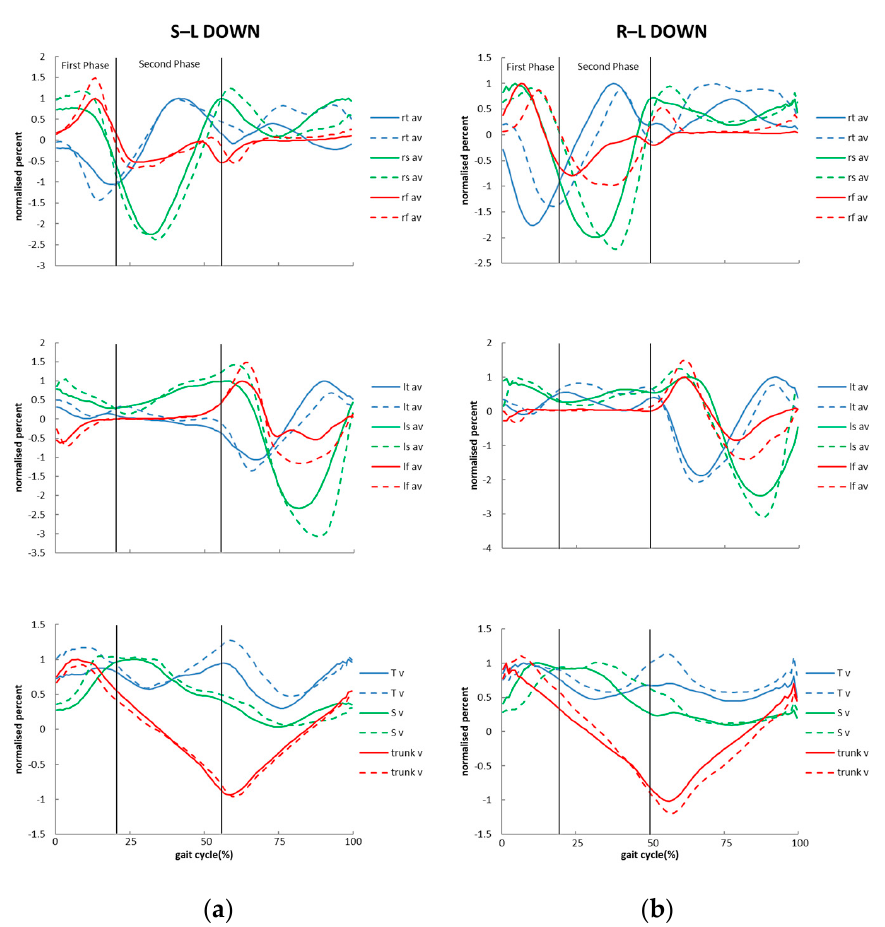
Figure 4. Average profile of the parameters: ( a ) during S-L DOWN and ( b ) during R-L DOWN. rt indicates the hip of leading limb, lt indicates the hip of trailing limb, rs indicates the knee of leading limb, ls indicates the knee of trailing limb, rf indicates the ankle of leading limb, lf indicates the ankle of trailing limb, trunk is trunk, T indicates the thigh of the leading limb, S indicates the shank of the leading limb, aa indicates angular acceleration, av indicates angular velocity, a indicates acceleration, and v indicates velocity. The dashed lines indicate transition stride. The solid lines indicate the stride before transition